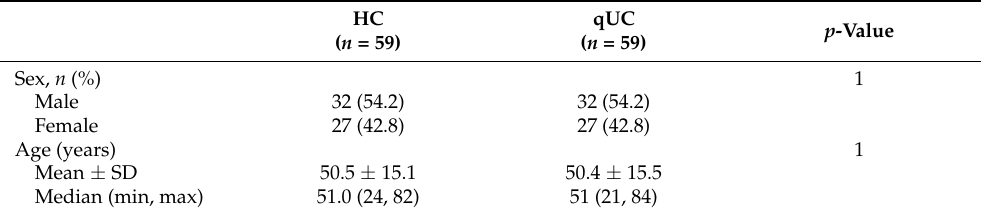
Table 1. Comparisons of the patients’ background between healthy controls and quiescent ulcerative colitis